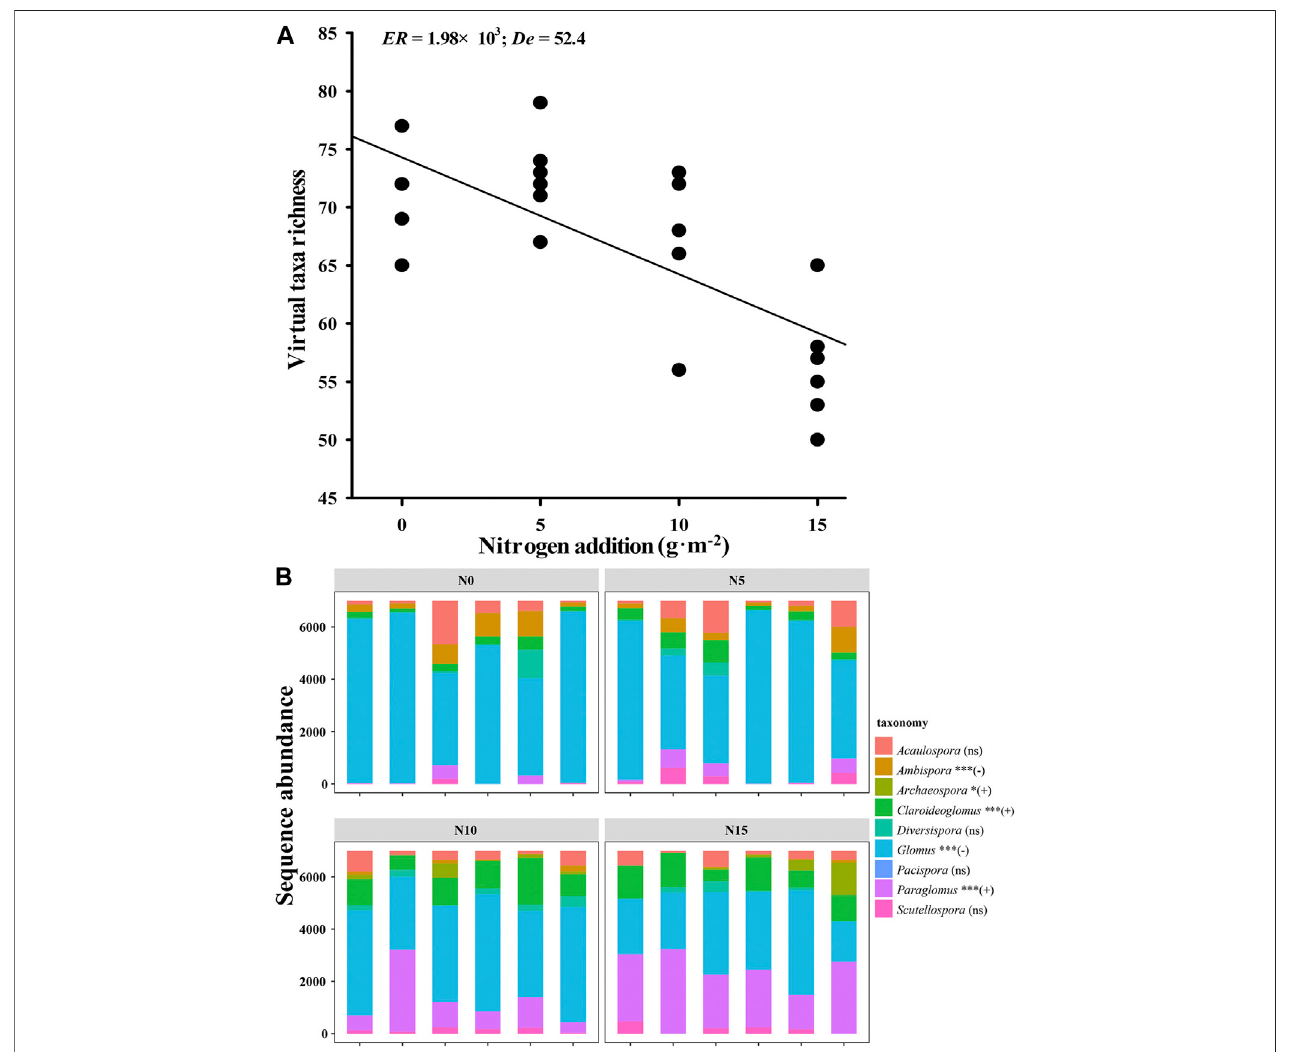
FIGURE1|(A) Virtualtaxarichness decreasedwithnitrogen addition(information-to-theory evidenceratio( ER ) (cid:2) 1.98 × 10 3 ;percentdevianceexplainedas( De ) (cid:2) 52.4; withsome overlapping points). ER > 1.5 means asigni fi cant relationship. (B) AMF abundance change ofthe rari fi ed sequence assigned tothe represented genera with four nitrogen addition treatments. The “ + ” or “–” sign in parentheses means signi fi cant increase or decrease in sequence abundance with nitrogen addition, while “ ns ” means insigni fi cance.